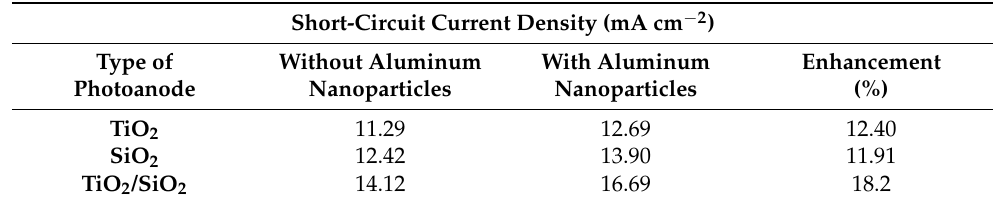
Table 3. Absorption enhancement and short-circuit current density for TiO 2 , SiO 2 and TiO 2 /SiO 2 with and without aluminum